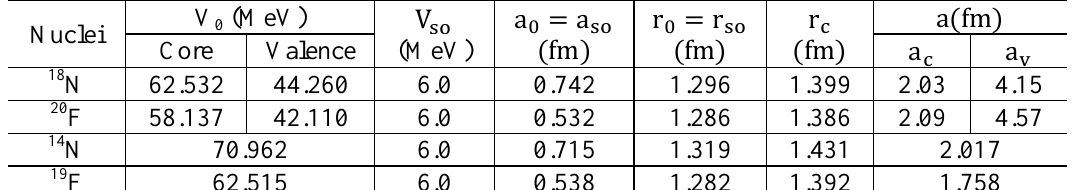
Table : The WS parameters and size parameters.